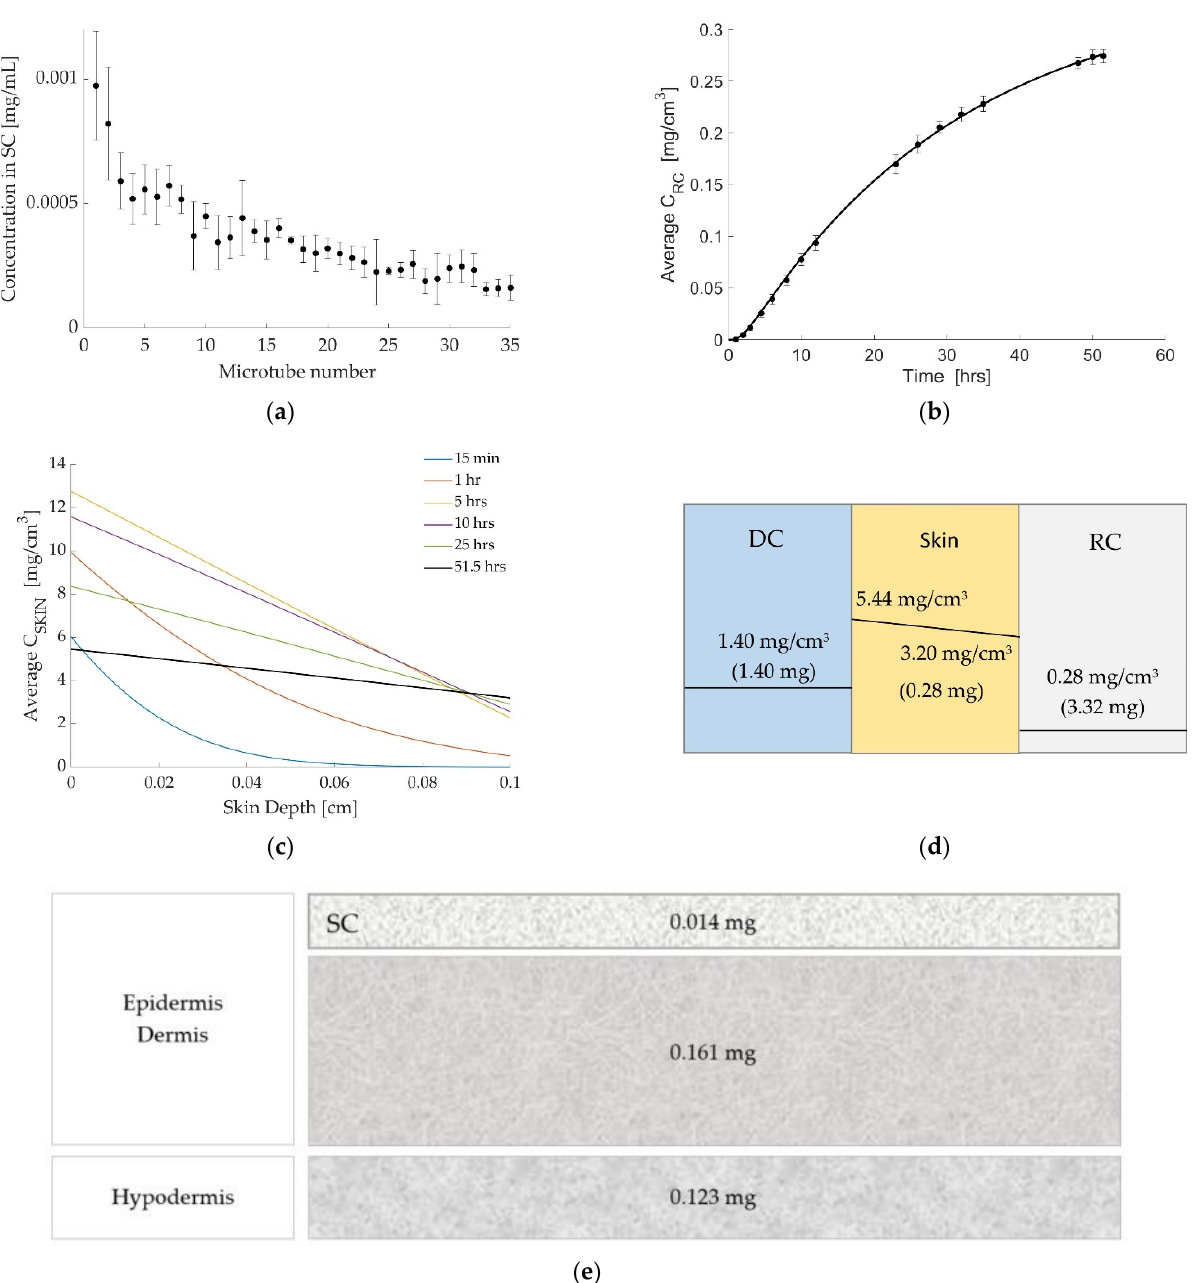
Figure 4. Diclofenac at 32 °C. ( a ) Tape stripping results (mean of all replicates ± standard deviation). Microtube no. 1 represents tapes no. 1–2 in the top layer of SC and no. 35 represents tapes no. 69–70. ( b ) Simulated release curve (solid line) and experimental results (marker). ( c ) Simulated concentration profiles in the skin at different times. ( d ) The concentration and the amount of drug in each layer at the end of the simulation, showing discontinuity between layers. ( e ) The measured amount of drug in the stratum corneum, rest of epidermis and dermis, and hypodermis at the end of the experiment.